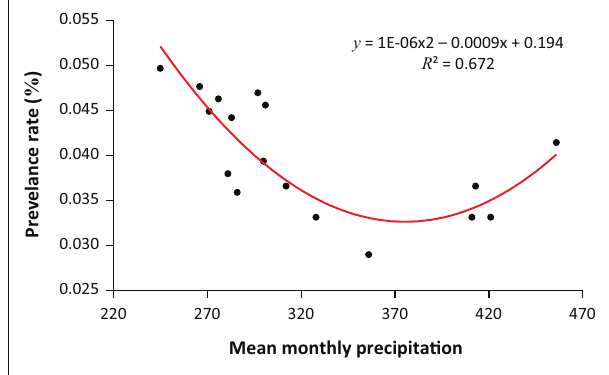
FIGURE 8: Relationship between malaria prevalence and mean monthly